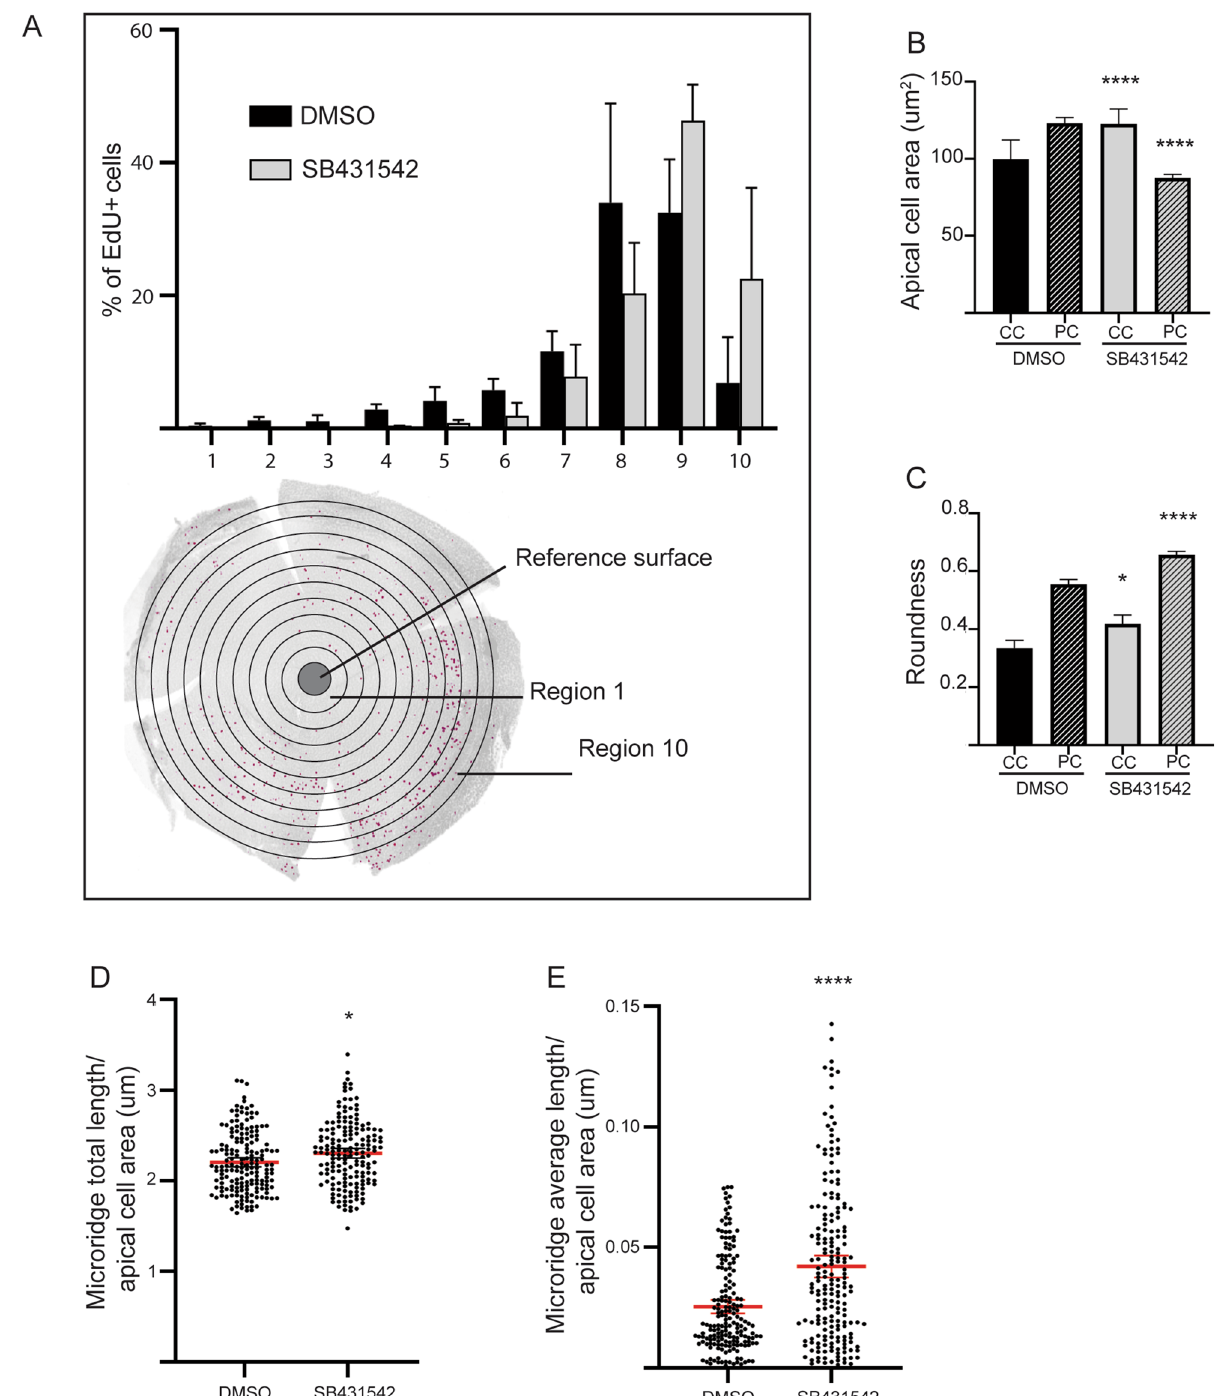
Figure 10. TGF-beta receptor inhibitor affects cell dynamics and morphology during wound closure. ( A ) The distribution of EdU+ cells, across the corneal radius from the central cornea (region 1) to the periphery (region 10), indicates a displacement of proliferation towards corneal periphery. n = 3 per treatment. ( B ) Quantification of apical cell area at 3HPW shows an increase of this parameter in central cornea and decrease in peripheral cornea upon TGF-beta receptor inhibition. Cells from 3 eyes were pooled for analysis (n-numbers after removal of outliers are: DMSO-CC, 88, DMSO-PC, 484, TGF-beta receptor inhibition-CC, 91, TGF-beta receptor inhibition-PC, 513). ( C ) Quantification of roundness at 3HPW indicates and increase of roundness in central and peripheral cornea upon TGF-beta receptor inhibition. Cells from 3 eyes were pooled for analysis (n-numbers after removal of outliers are: DMSO-CC, 85, DMSO-PC, 484, TGF-beta receptor inhibition-CC, 91, TGF-beta receptor inhibition-PC, 515). ( D , E ) TGF-beta receptor inhibition leads to an increase of microridge total length ( D ), and average length ( E ), per cell at 3HPW on peripheral cornea. Cells from 3 eyes were pooled for analysis (n-numbers after removal of outliers are: DMSO, 175, TGF-beta receptor inhibition, 169 ( D ), DMSO, 185, TGF-beta receptor inhibition, 198 ( E ). Data represent mean + stdev ( A ), or mean + 95% confidence interval ( B – E ), P* < 0.05, P**** < 0.0001. Kruskal–Wallis test followed by Dunn’s test for multiple comparisons. HPW: hours